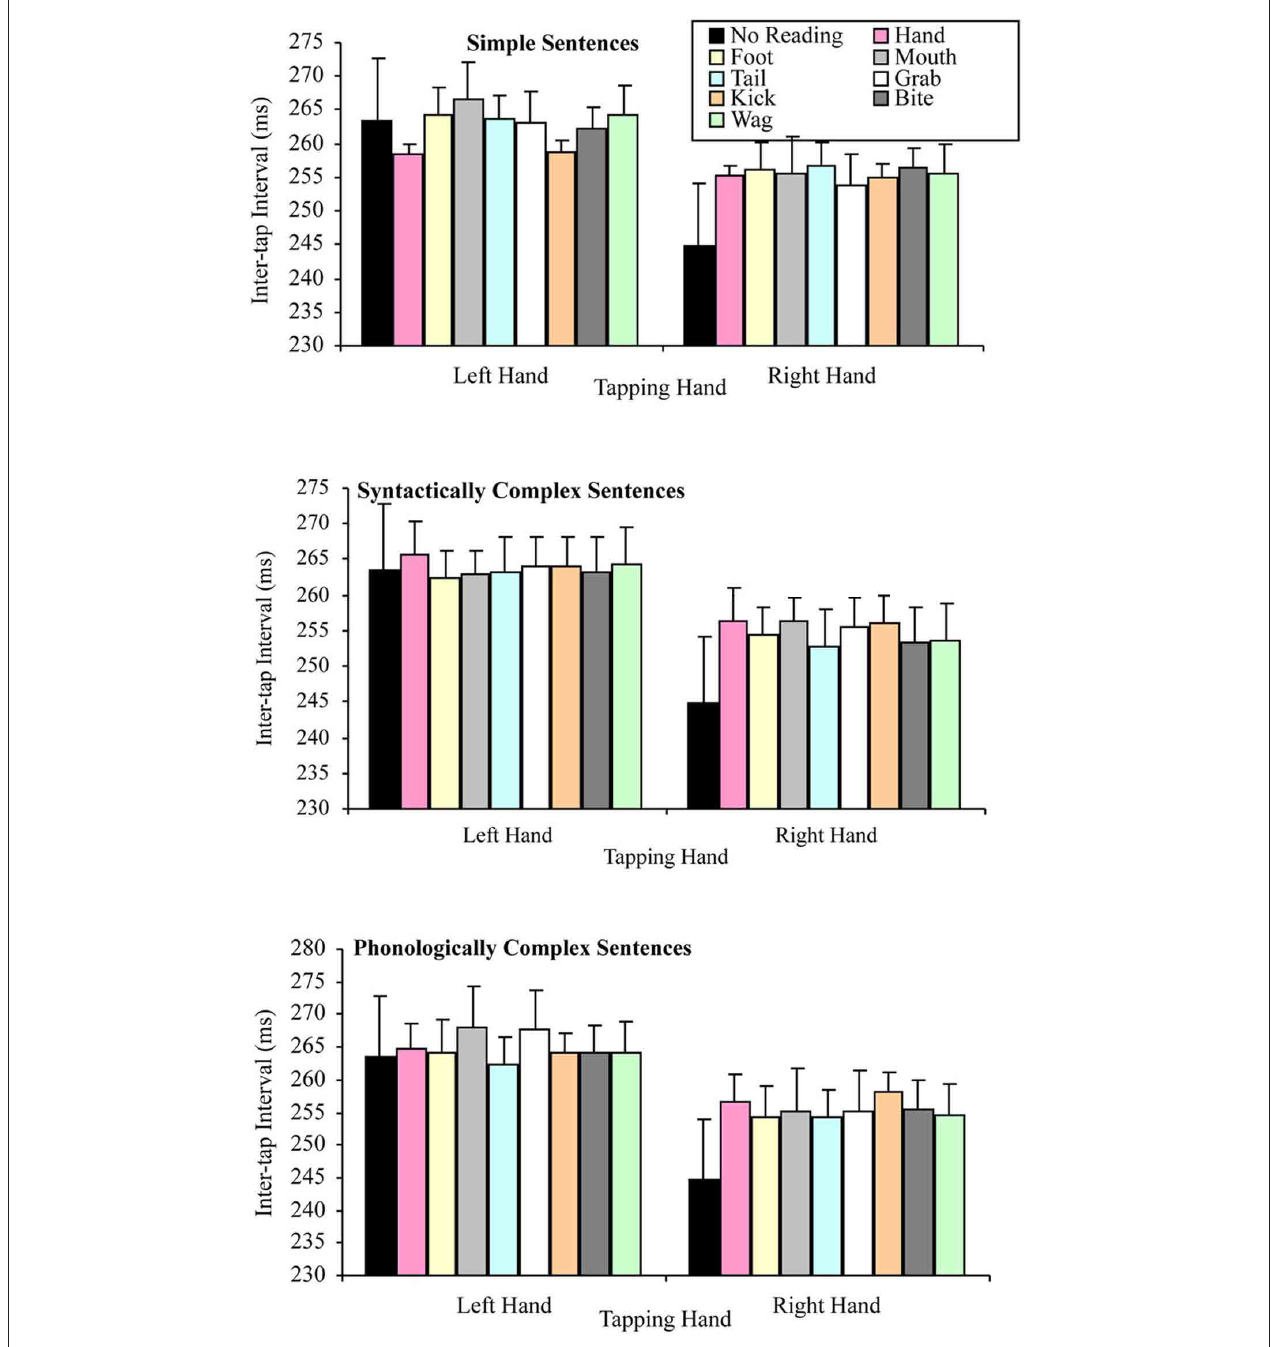
FIGURE 8 | Mean inter-tap intervals for the tapping hand × target word conditions for each type of sentence complexity in the combined data set (error bars represent the standard error of the mean).